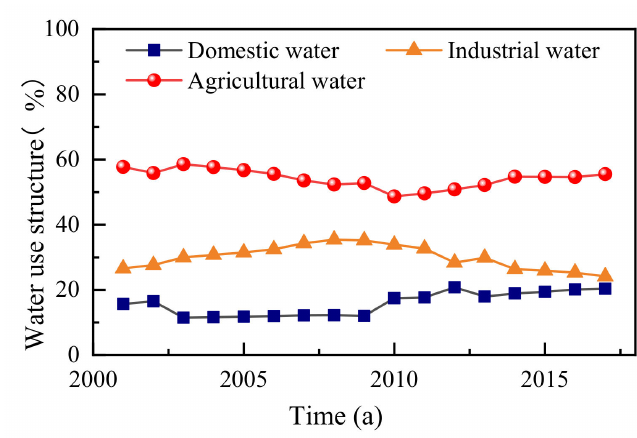
Figure 7. Change in basin water use